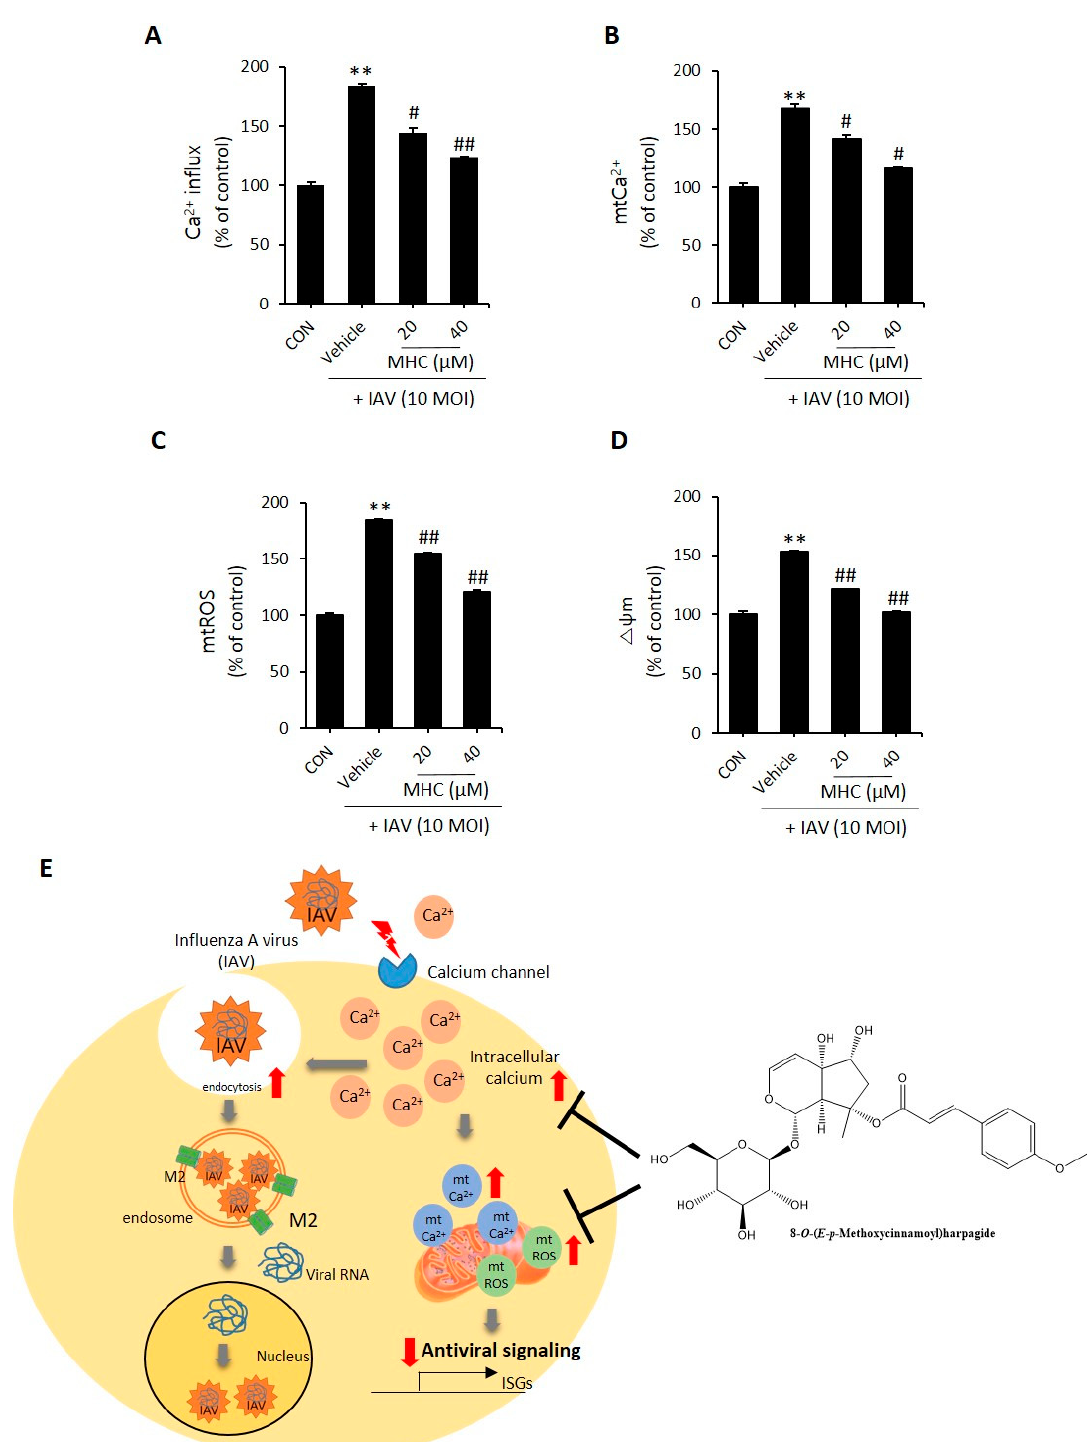
Figure 3 . A549 cells. Cells were infected with GFP encoded-H1N1 (A/PR8/34) virus for 2 h and then treated with MCH for 24 h before staining with a fluorescent dye. ( A ) Intracellular Ca 2+ was measured using Fluo-4AM. ( B ) Mitochondrial Ca 2+ was measured using Rhod-2 as a selective mtCa 2+ staining dye. ( C ) Mitochondrial ROS was measured using mitoSOX as a selective mtROS staining dye. ( D ) Mitochondrial membrane potential (MMP, △ ψ m) was stained with Dioc6(3). ( E ) Graphical abstract of MCH. All data were detected and quantified using a flow cytometer. The bar graphs show the mean ± SD of three independent experiments [** p < 0.01 compared with the control (DMSO), # p < 0.05 and ## p < 0.01 compared with the vehicle (IAV-infected